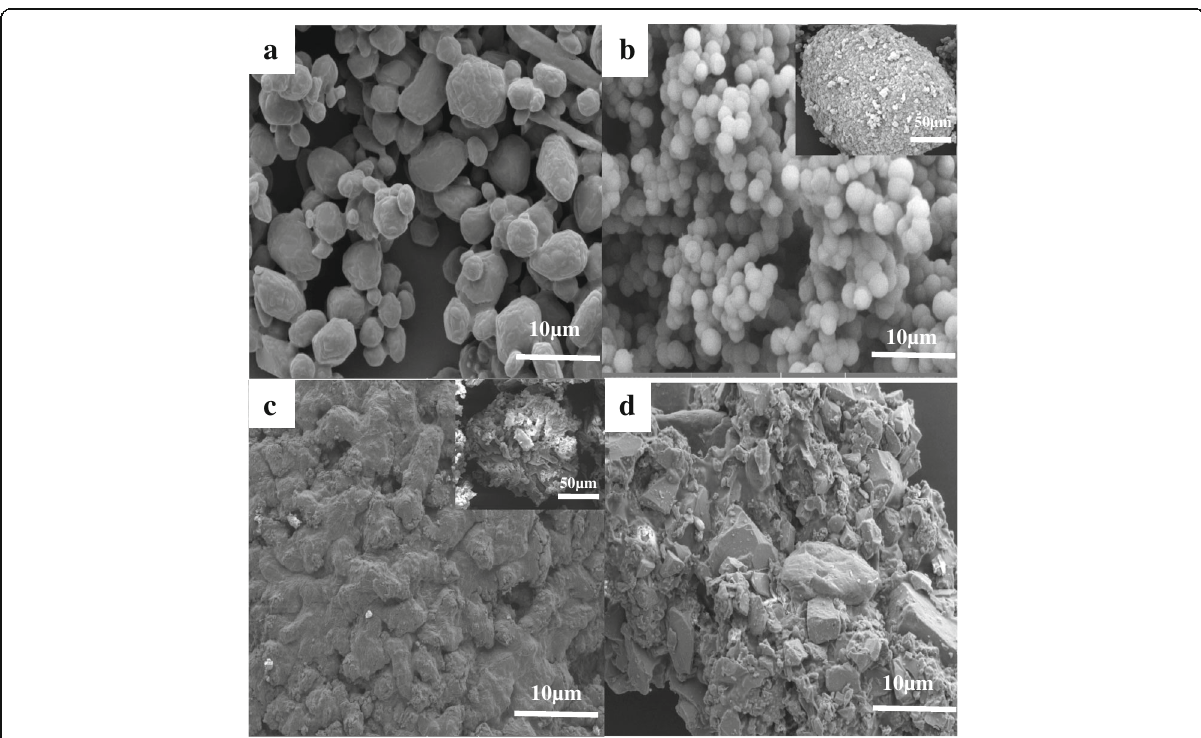
Fig. 4 SEM images of the uncoated RDX ( a ), RDX/MUF-1 ( b ), RDX/MUF-2 ( c ), and RDX/MUF-3 ( d ); corresponding images with low magnification are